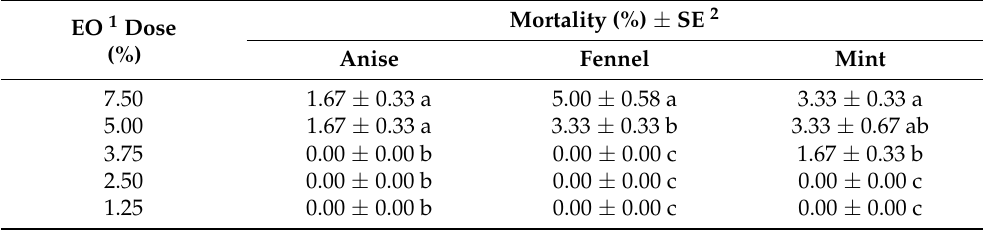
Table 2. Residual contact toxicity of essential oil-based nano-emulsions against B. oleae adult flies. Mean mortality values were calculated with four replicates (n = 20). Different letters indicate significant differences among the values in the same column (Dunn’s test, p < 0.05).